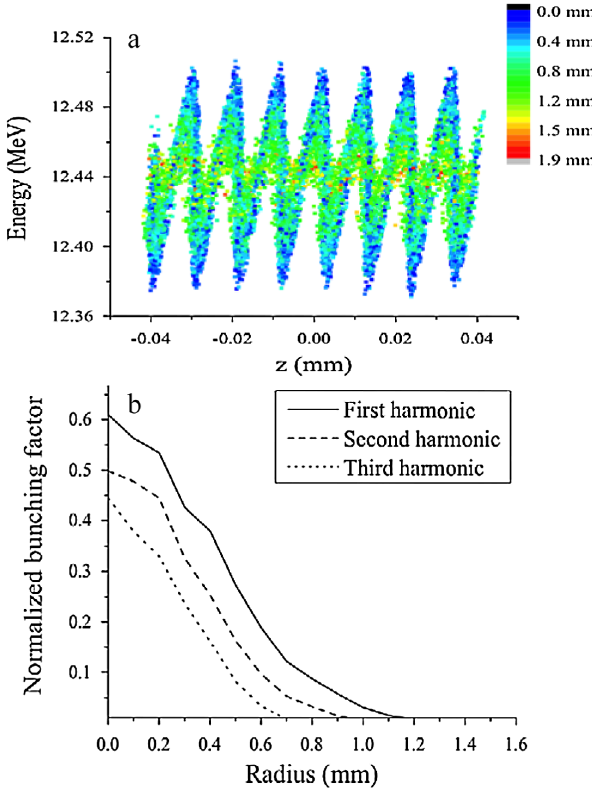
6. (Color) TREDI simulations. Laser power 34 MW, (cid:5) x;y ¼ 380 (cid:1) m . (a) The longitudinal phase space distribution of elec- trons at the exit of the undulator and (b) normalized bunching coefficients for the first, second, and third harmonics of the bunched beam as a function of radius. The color code represents the radial distance of electrons from the beam